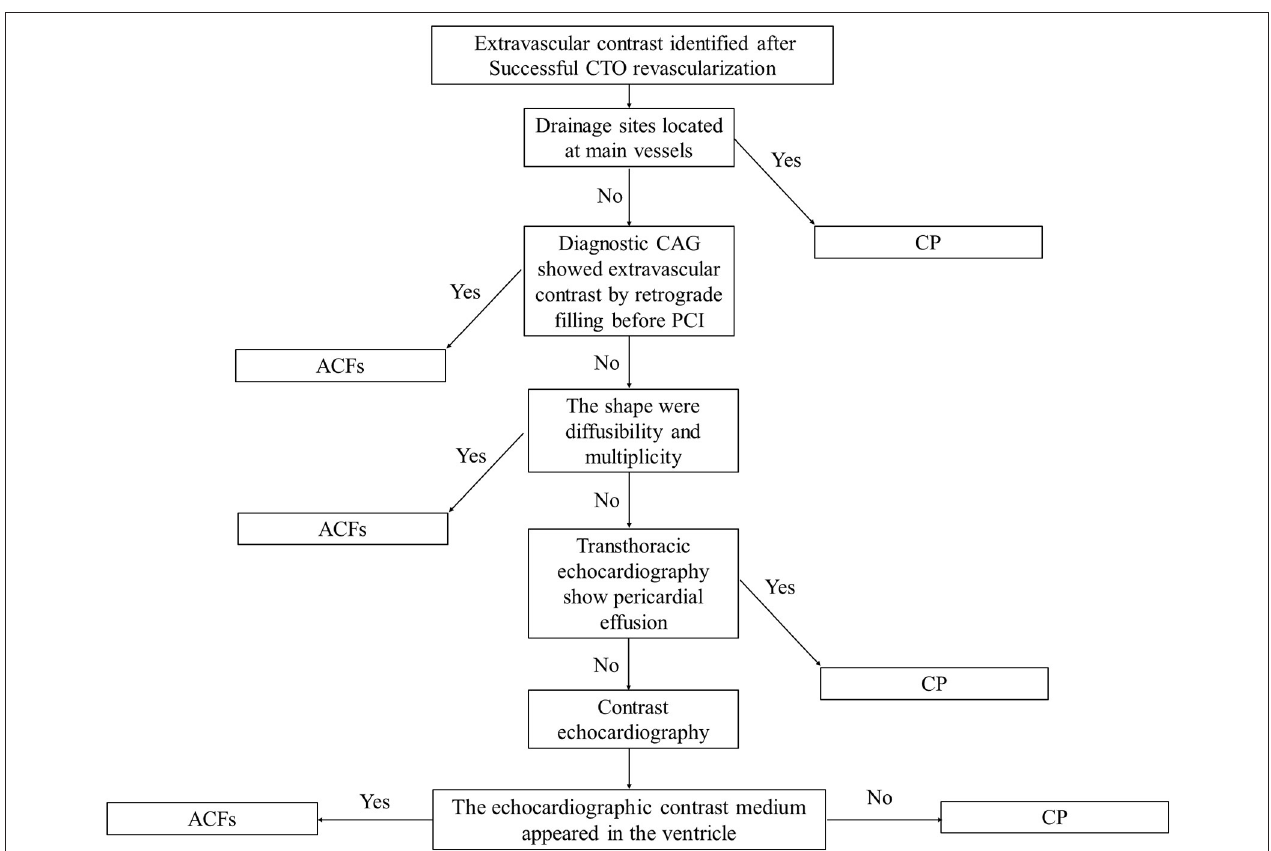
FIGURE 4 | A flow chart used to distinguish between coronary perforation (CP) and ACFs after CTO reopening.